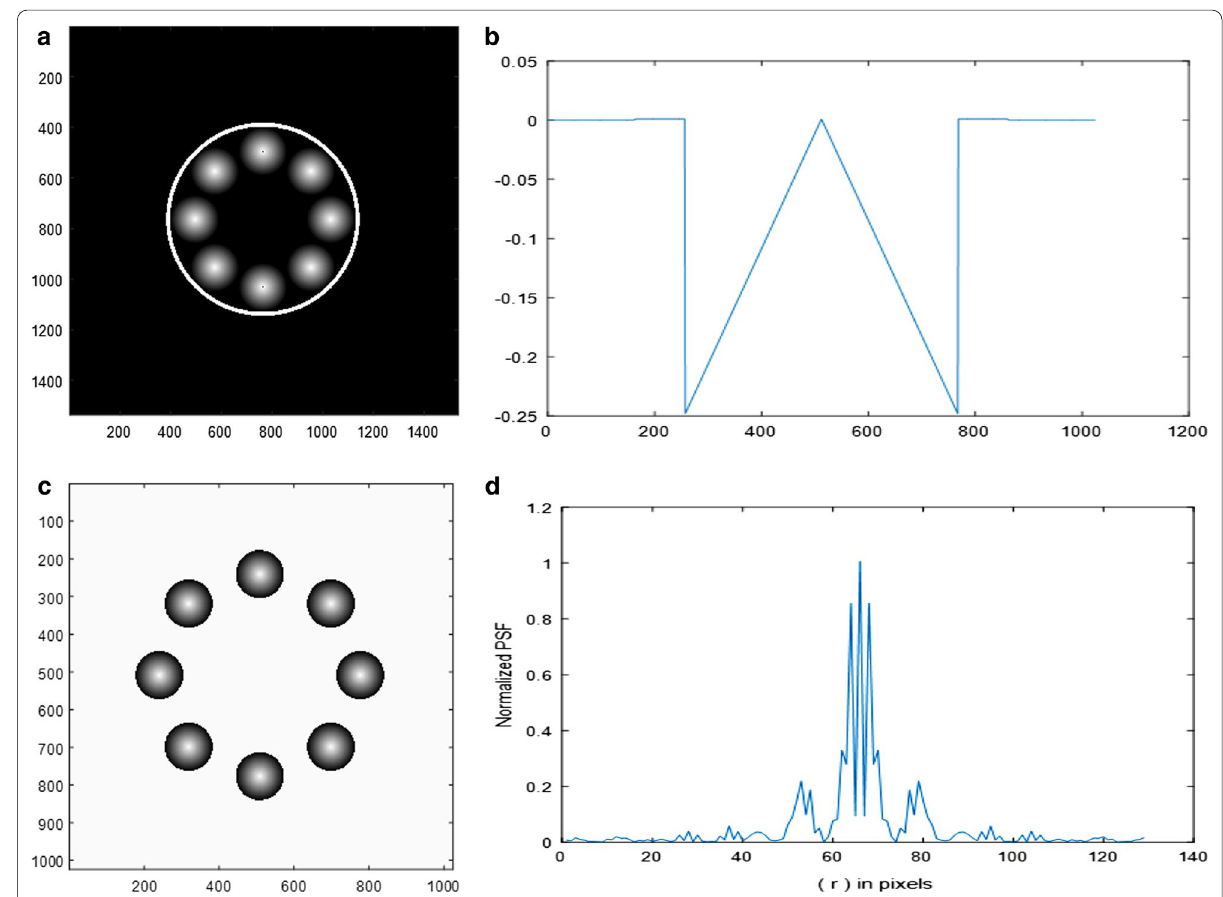
Fig. 1 a Eight conic apertures placed in tangent with the annular aperture. The annular width 16 pixels and the external radius 350 pixels. While = = the radius of each conic aperture 64 pixels. b Plot of the conic aperture of radius 256 pixels placed at 512, 512 pixels. c Eight equally spaced = = conic apertures where the centers placed at fixed distance 268 pixels from the center placed at (512, 512). The radius of each conic aperture 64 = = pixels. d Normalized PSF as a function of radial distance r (pixels) in the Fourier plane for a lens limited by the aperture shown in Figure c